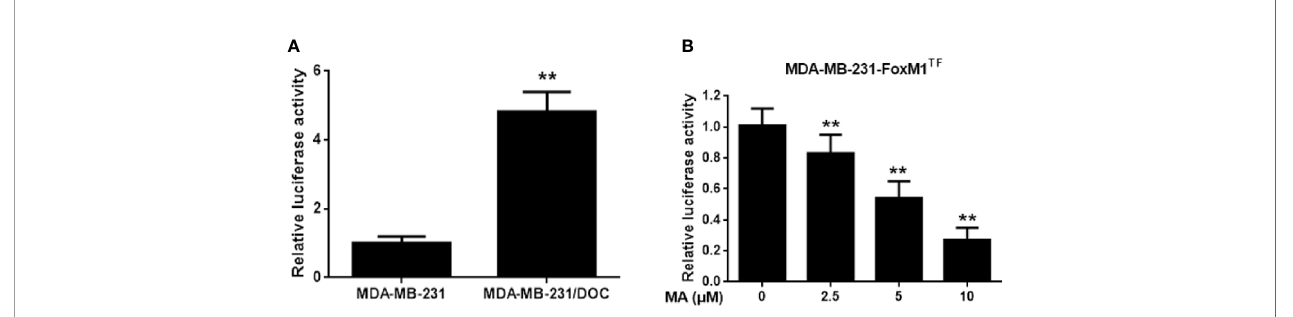
FIGURE 4 | The effect of maslinic acid (MA) on the transcriptional activity of FoxM1 in MDA-MB-231/DOC cells. (A) MDA-MB-231 and MDA-MB-231/DOC cells were transfected with FoxM1-luc reporter vector, and the transcriptional activity of FoxM1 was assessed. ** p < 0.01 vs. MDA-MB-231 group. (B) MDA-MB-231/ DOC-FoxM1 TF cells transfected with FoxM1-luc reporter vector were treated with or without MA for 24 h, and luciferase report assay was conducted to evaluate the transcriptional activity of FoxM1. ** p < 0.01 vs. control. All data were presented as means ± SD with three independent experiments, and triplicate repeats were included in each experiment.